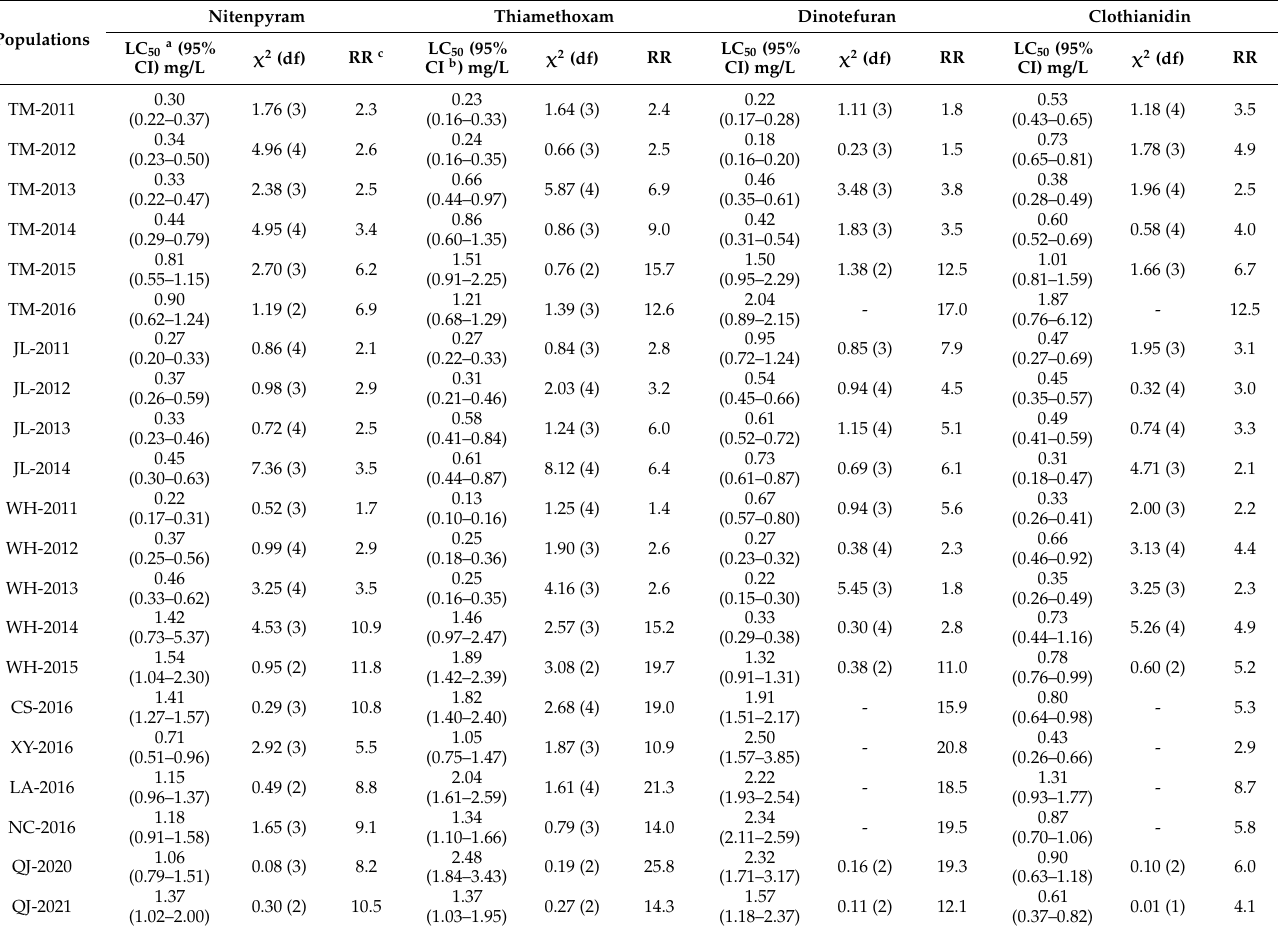
Table 3. The resistance to four neonicotinoid insecticides in S. furcifera field populations from 2011 to